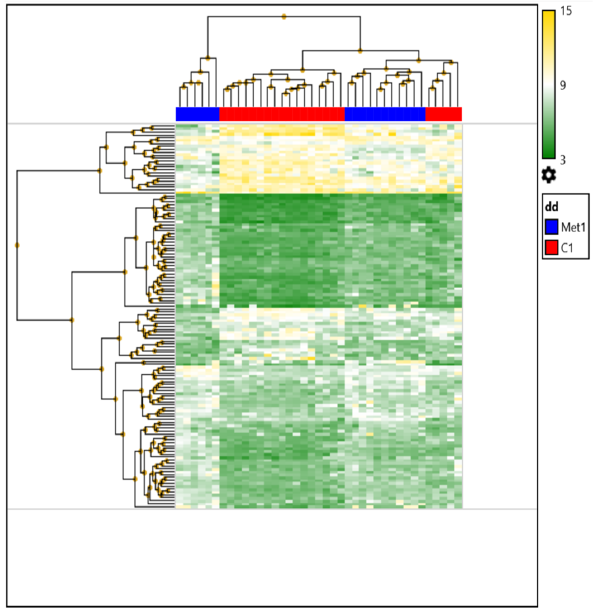
Figure 2. Heat map of DEG in tumors of patients with breast cancer before neoadjuvant chemotherapy, depending on the status of hematogenous metastasis.